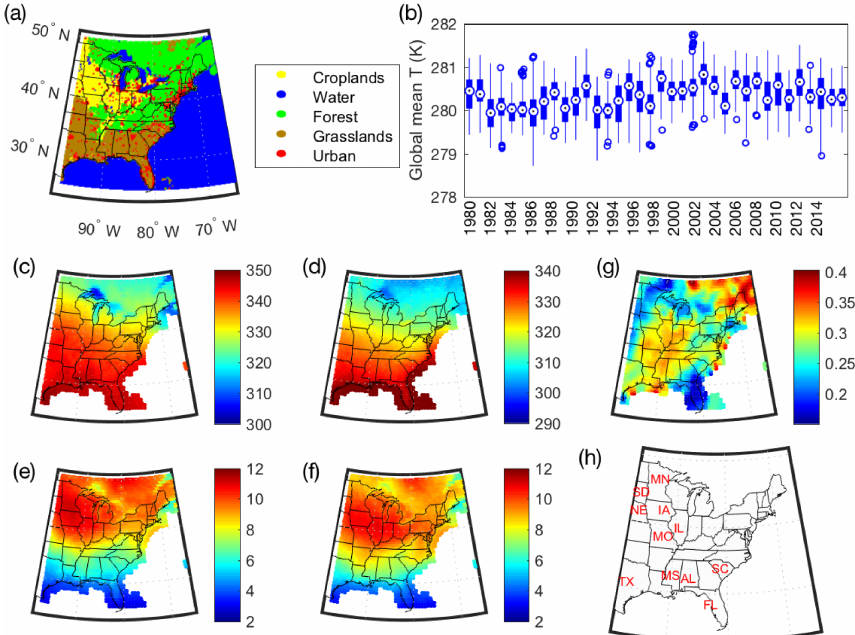
Figure 1. (a) The study domain used herein (25.5 ◦ –50 ◦ N, 97.5 ◦ –65 ◦ W) and five consolidated land use and land cover (LULC) classes as represented at a resolution of 0 . 05 ◦ × 0 . 05 ◦ from the MODIS land cover data set for 2014 (MCD12C). (b) A box plot of daily global mean JJA temperature values (K) (1980–2015) as computed from the MERRA-2 output. (c) Mean summertime (JJA, 1980–2015) maximum θ e and (d) minimum θ e (K) as computed from hourly T and q at 2m and surface pressure ( P ) in each MERRA-2 grid cell. Standard deviation of daily (e) maximum θ e and (f) minimum θ e (K) (JJA, 1980–2015). (g) Mean soil moisture estimates (1980–2015) from MERRA-2 used as a predictor in the ANN and computed as follows: the daily mean value for total profile soil moisture content (PRMC) for each grid cell is averaged over a spatial area of 3 × 3 grid cells centered on the grid cell of interest, and used to compute a 90-day running JJA mean soil moisture (m 3 m − 3 ). Panel (h) shows the location of states that are explicitly referred to